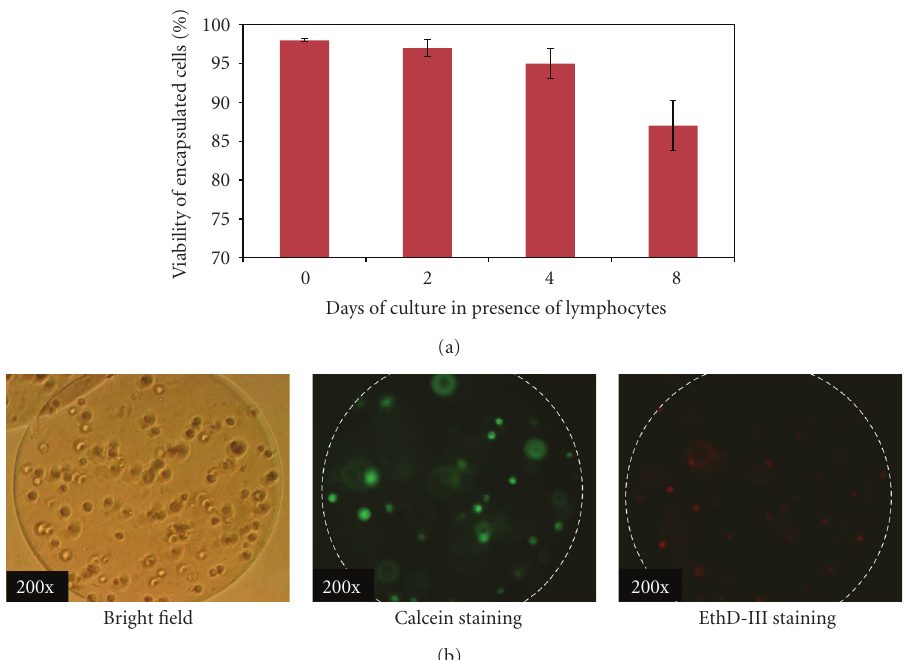
Figure 7: Immunoprotective potential of the AP-PEG-A membrane. Microcapsules were prepared by microencapsulating 2 × 10 6 Bac-null transduced H9c2 cells/ml of alginate and cultured in DMEM+10% FBS in 37 ◦ C incubator for 8 days in presence of lymphocytes. Medium was replaced on every alternate day. Samples were collected at regular intervals and subjected to viability test. Viability tests were done by using the calcein AM (showing viable cells in green) and ethidium homopolymer (showing dead cells in red) dye. The data represent the mean of three independent studies, and error bars represent standard error of the mean (a). Representative bright field and fluorescent images of a capsule encapsulating the cells under 200x magnifications in a fluorescence microscope (b). The white-dotted circles show the peripheral surface of the capsules.